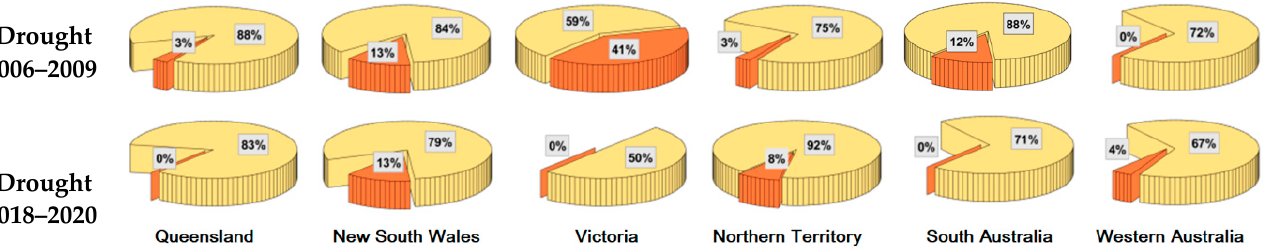
Figure 5. Drought frequency among the six regions during Drought 2006–2009 and 2018–2020 (Note: the yellow part represents mild droughts and the orange part represents moderate droughts).